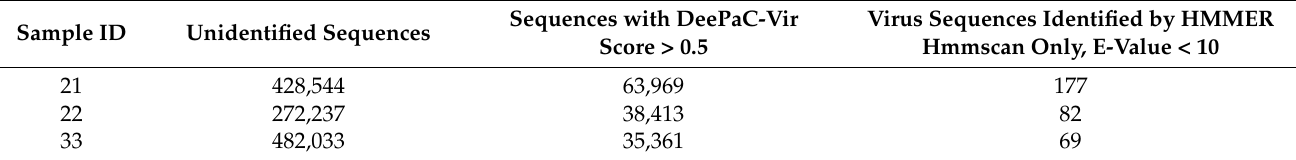
Table 2. The numbers of sequences in clustered fasta files and the numbers of sequences that were not assigned to any taxon. Sample